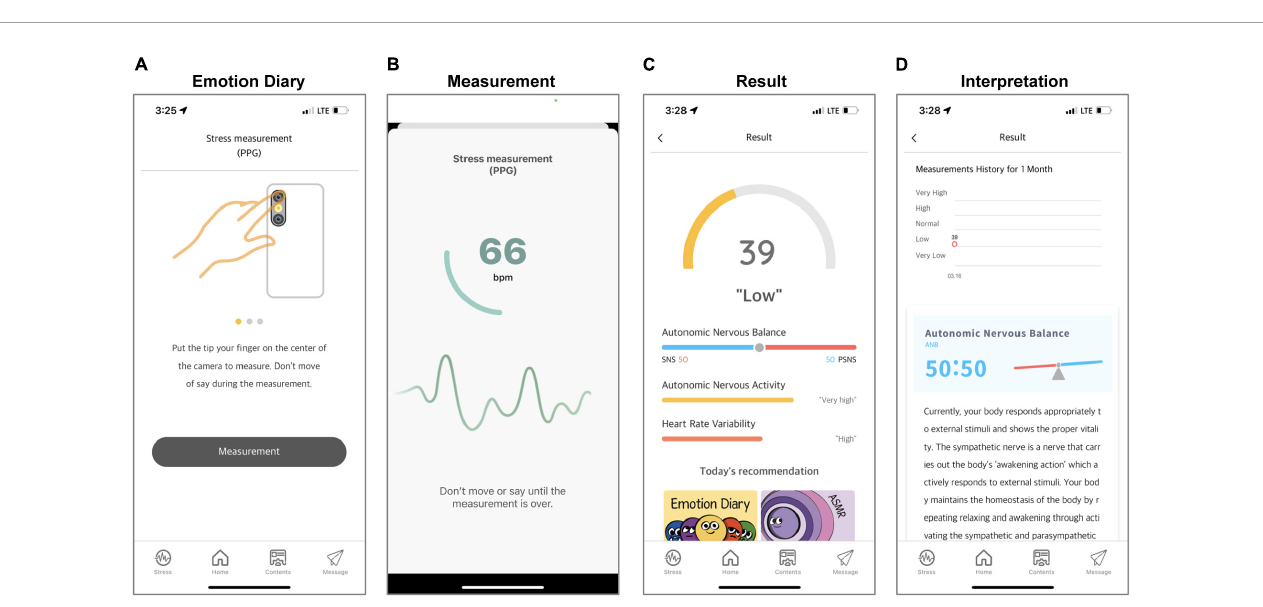
FIGURE7 Screenshots of the objective stress monitoring. The “Guide” shows how to measure PPG and guides participants on situations to pay attention to during PPG measurement (A) . When the measurement starts, the measured pulse rate is displayed on the screen, and the progress is displayed in a circle to check that 1 min has elapsed (B) . When the measurement is completed, autonomic nervous balance, autonomic nervous activity, heart rate variability, and stress index are displayed based on the results (C) . Participants can see the change in their results on the result screen and check the interpretation of the results (D) . The content was presented in Korean, but the examples in this figure are presented in English to aid understanding for international